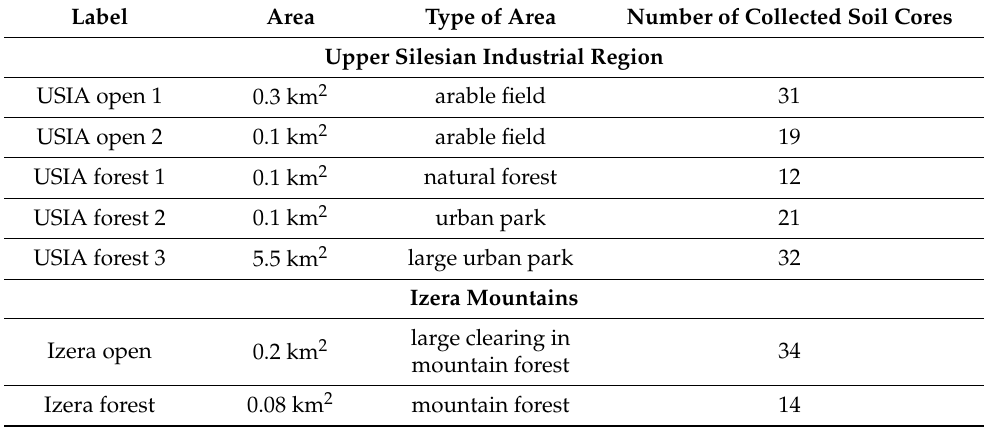
Table 2. List of study areas, labels used in the text, types of area, and number of collected soil cores.